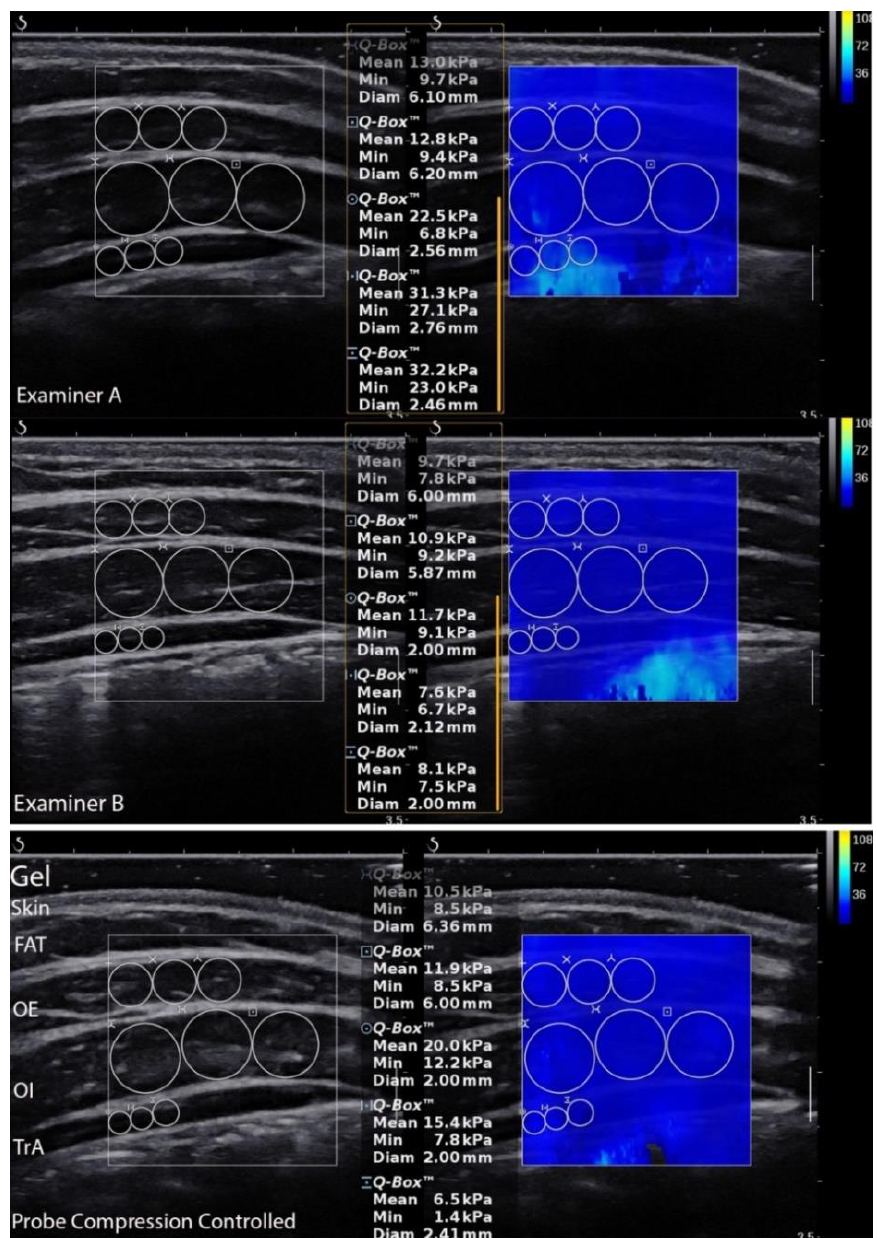
Figure 2. Ultrasound scans of the lateral abdominal muscles performed by all examiners and shear modulus measurements. FAT—superficial fat layer; OE—oblique external; OI—oblique internal; TrA—transversus abdominis muscle.